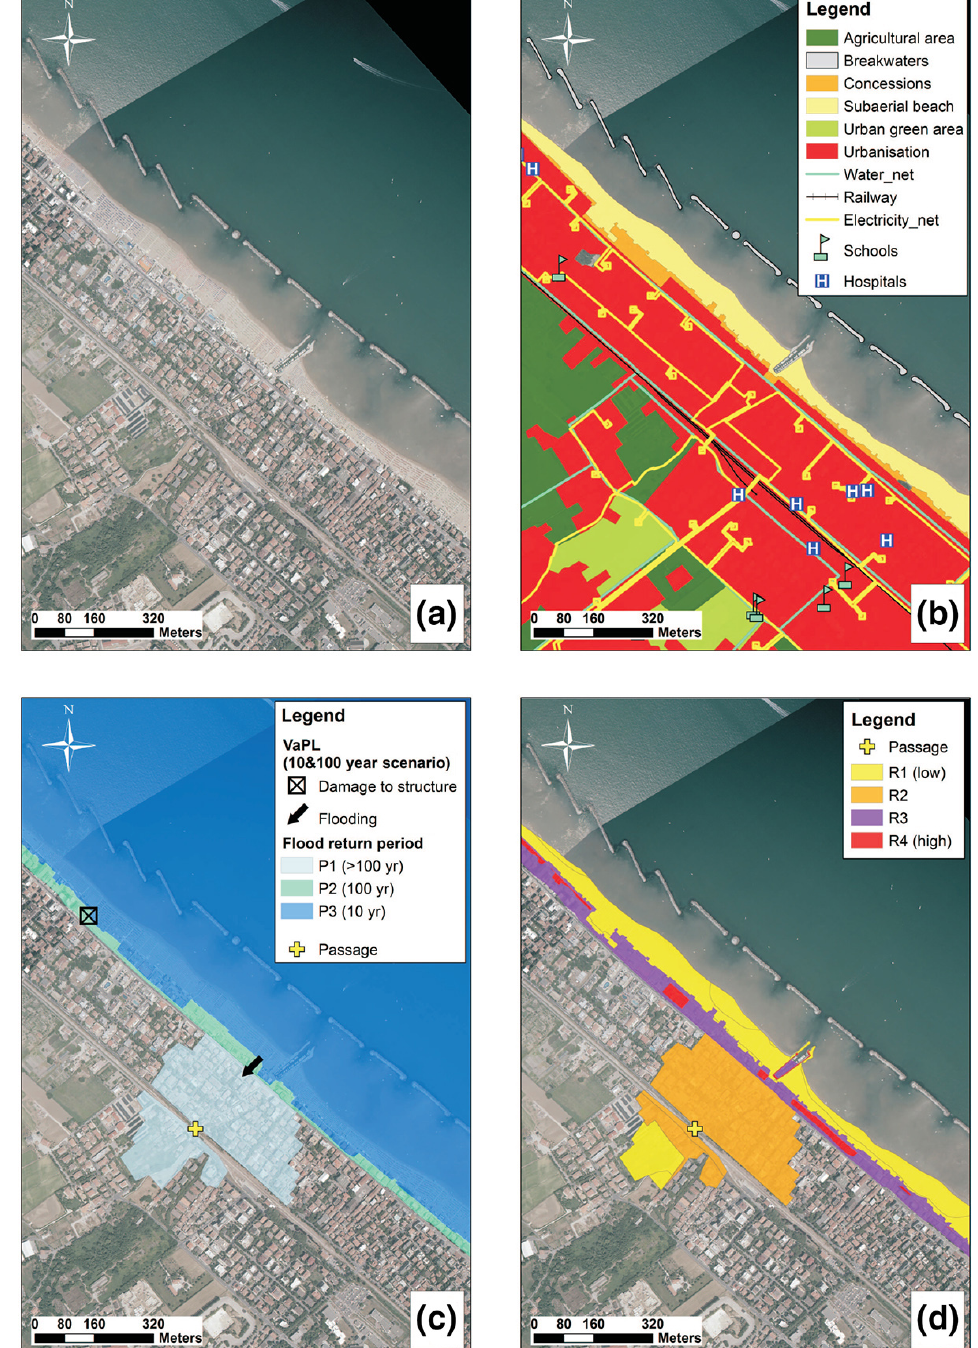
Figure 5. The Viserba, Rimini province, site. (a) 2005 aerial photograph of the area (AGEA flight), (b) land use map and sensitive structures, (c) hazard map, and (d) risk map. The symbols in panel (c) represent the vulnerability typologies of the 10- and 100-year return period scenarios. The yellow cross represents the location of a low-lying